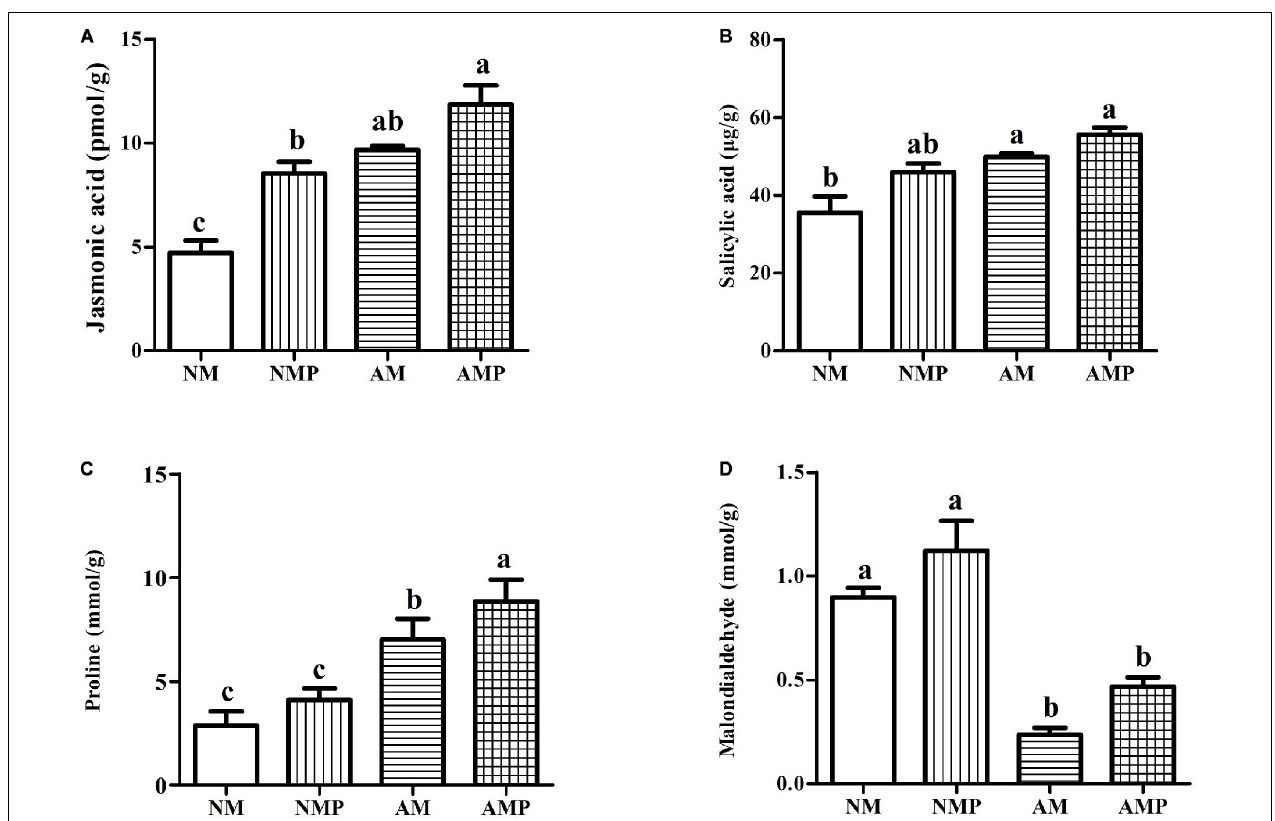
FIGURE 4 | Jasmonic acid (A) , salicylic acid (B) , proline (C) , and malondialdehyde (D) contents under arbuscular mycorrhizal and disease treatments. NM = uninoculated with S. tortuosa , AM = inoculated with S. tortuosa , NMP = NM inoculated with C. lentis , and AMP = AM inoculated with C. lentis . Different lowercase letters on the bars means there is significant difference across treatments at P < 0 . 05 by Tukey’s HSD